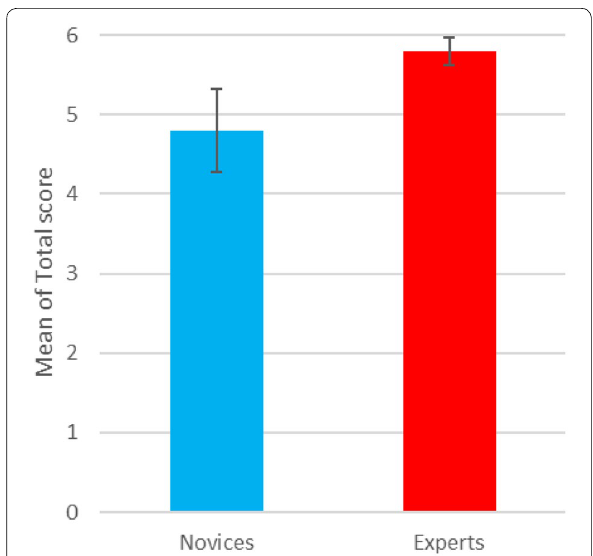
Fig. 11 Mean and SEM of the total score for deciding on the water discharge